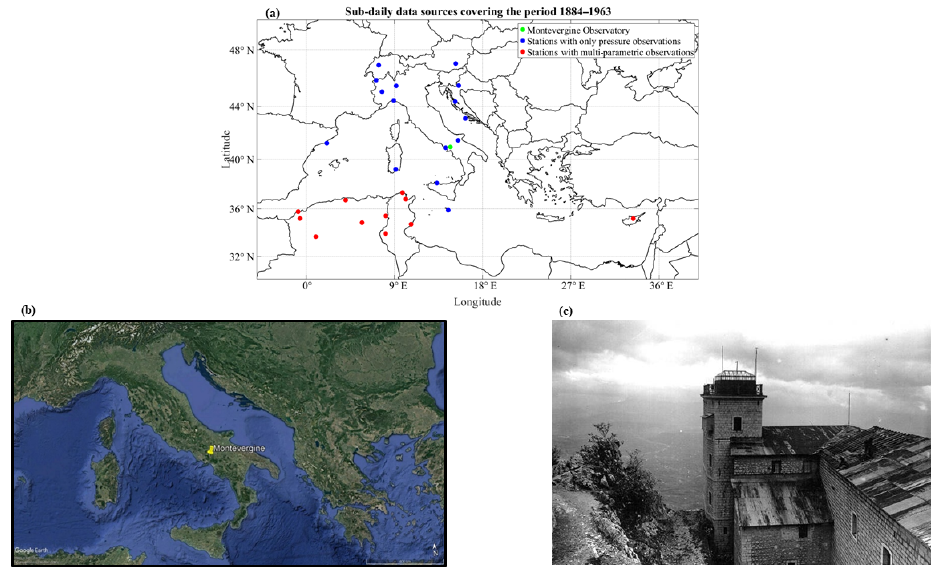
Figure 1. Panel (a) : map of Mediterranean region showing the location of sub-daily meteorological data available in digital format for the period 1884–1963. Blue dots represent the stations including only atmospheric pressure measurements, and red dots represent the stations for which multi-parametric meteorological observations are available. Data sources have been provided by the International Surface Pressure Databank version 4.7 (Compo et al., 2019; https://rda.ucar.edu/datasets/ds132.2/index.html?sstn=17606&spart=exactstationVie, last access: 29 January 2020) and by Ashcroft et al. (2018) datasets. Panel (b) shows the central Mediterranean region, including Montevergine (high- lighted via a yellow pin). Montevergine is also marked in panel (a) as a green dot. Image credits: © Google Earth, Data Sio, NOAA, U.S. Navy, NGA, GEBCO. Panel (c) presents an old photo of the Montevergine Observatory tower, situated near the top of the Partenio mountain chain on the north-eastern side of the Montevergine abbey. Image courtesy of the Italian Air Force (http://www.meteoam.it/page/montevergine, last access: 25 April